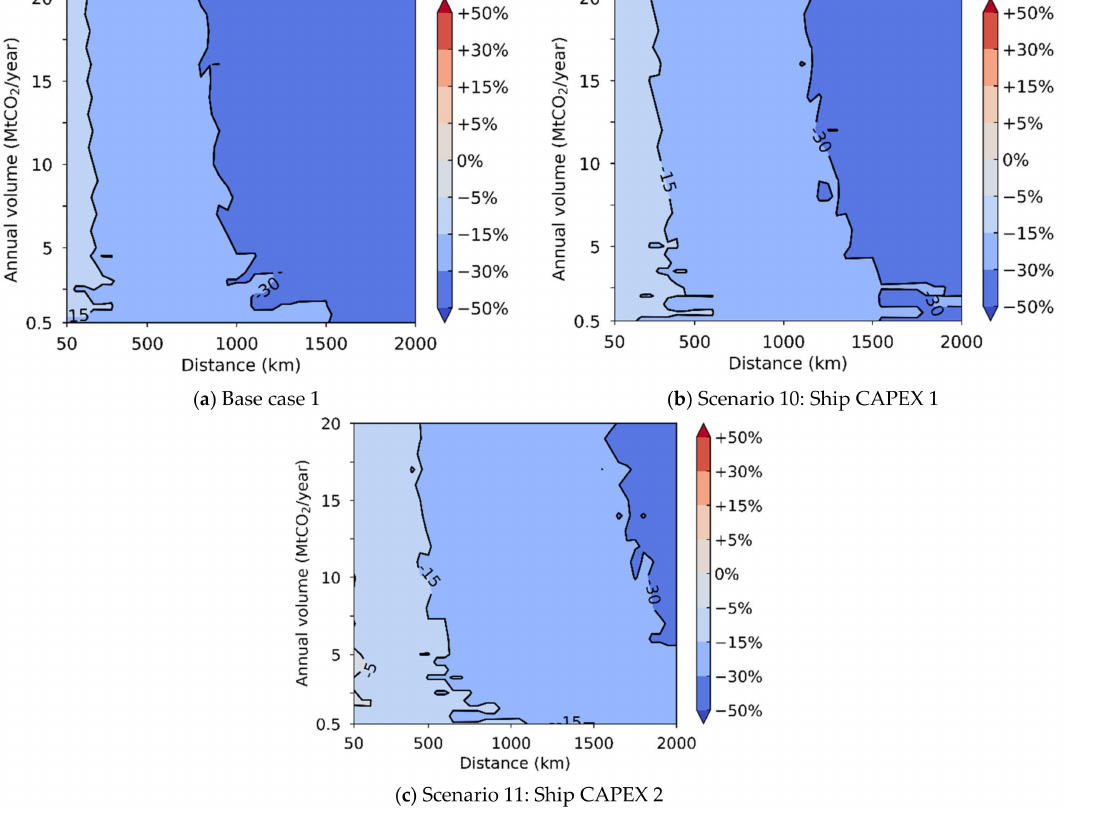
Figure 9. Cost comparison maps showing relative cost reductions (%) enabled by the 7 barg compared to the 15 barg shipping option in the case of ship transport between two harbours considering different ship CAPEX